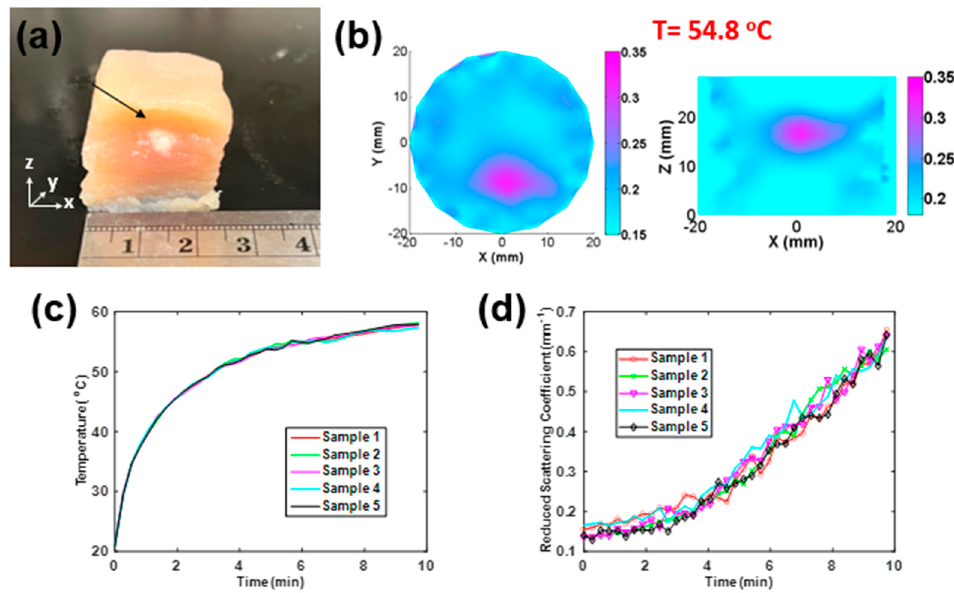
Figure 4. ( a ) Photograph of a chicken breast sample treated by HIFU along the z - axis. ( b ) Recovered µ (cid:48) s distribution in XY and YZ planes (t = 54.8 ◦ C). ( c ) Temperature versus time and ( d ) recovered µ (cid:48) s versus time of five chicken breast samples treated by HIFU in 10 min per sample.